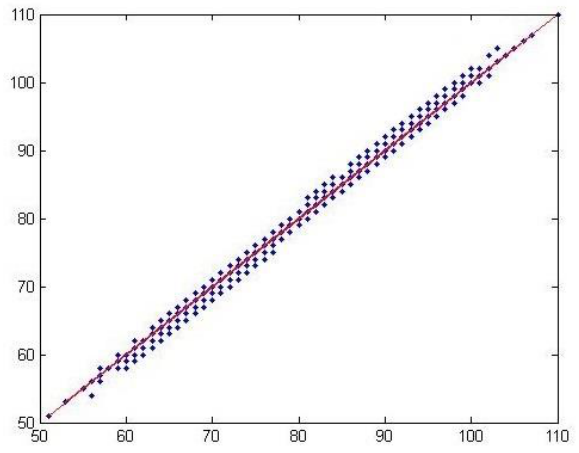
Figure 8. The Scatter plot drawn between Figure 7 (a) and 7